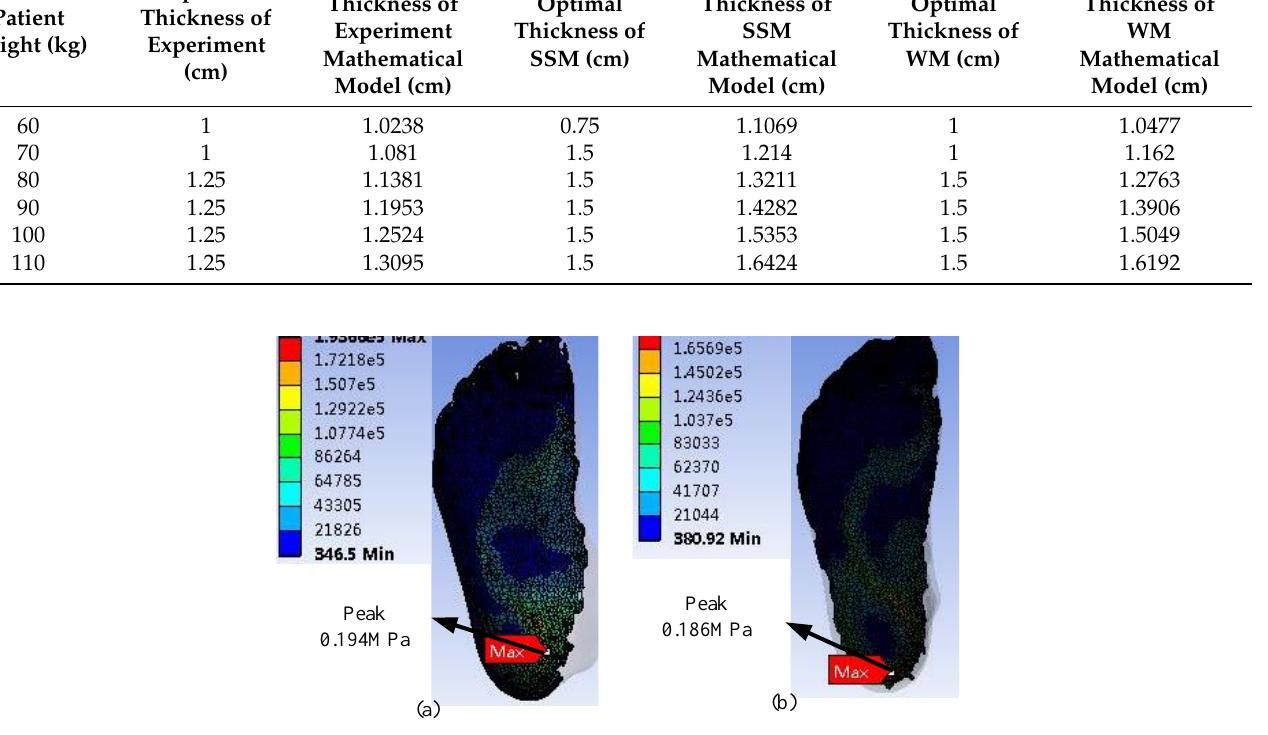
Figure 8. Plantar pressure. ( a ) WM and ( b ) SSM. Table 4. Validation of plantar pressure from